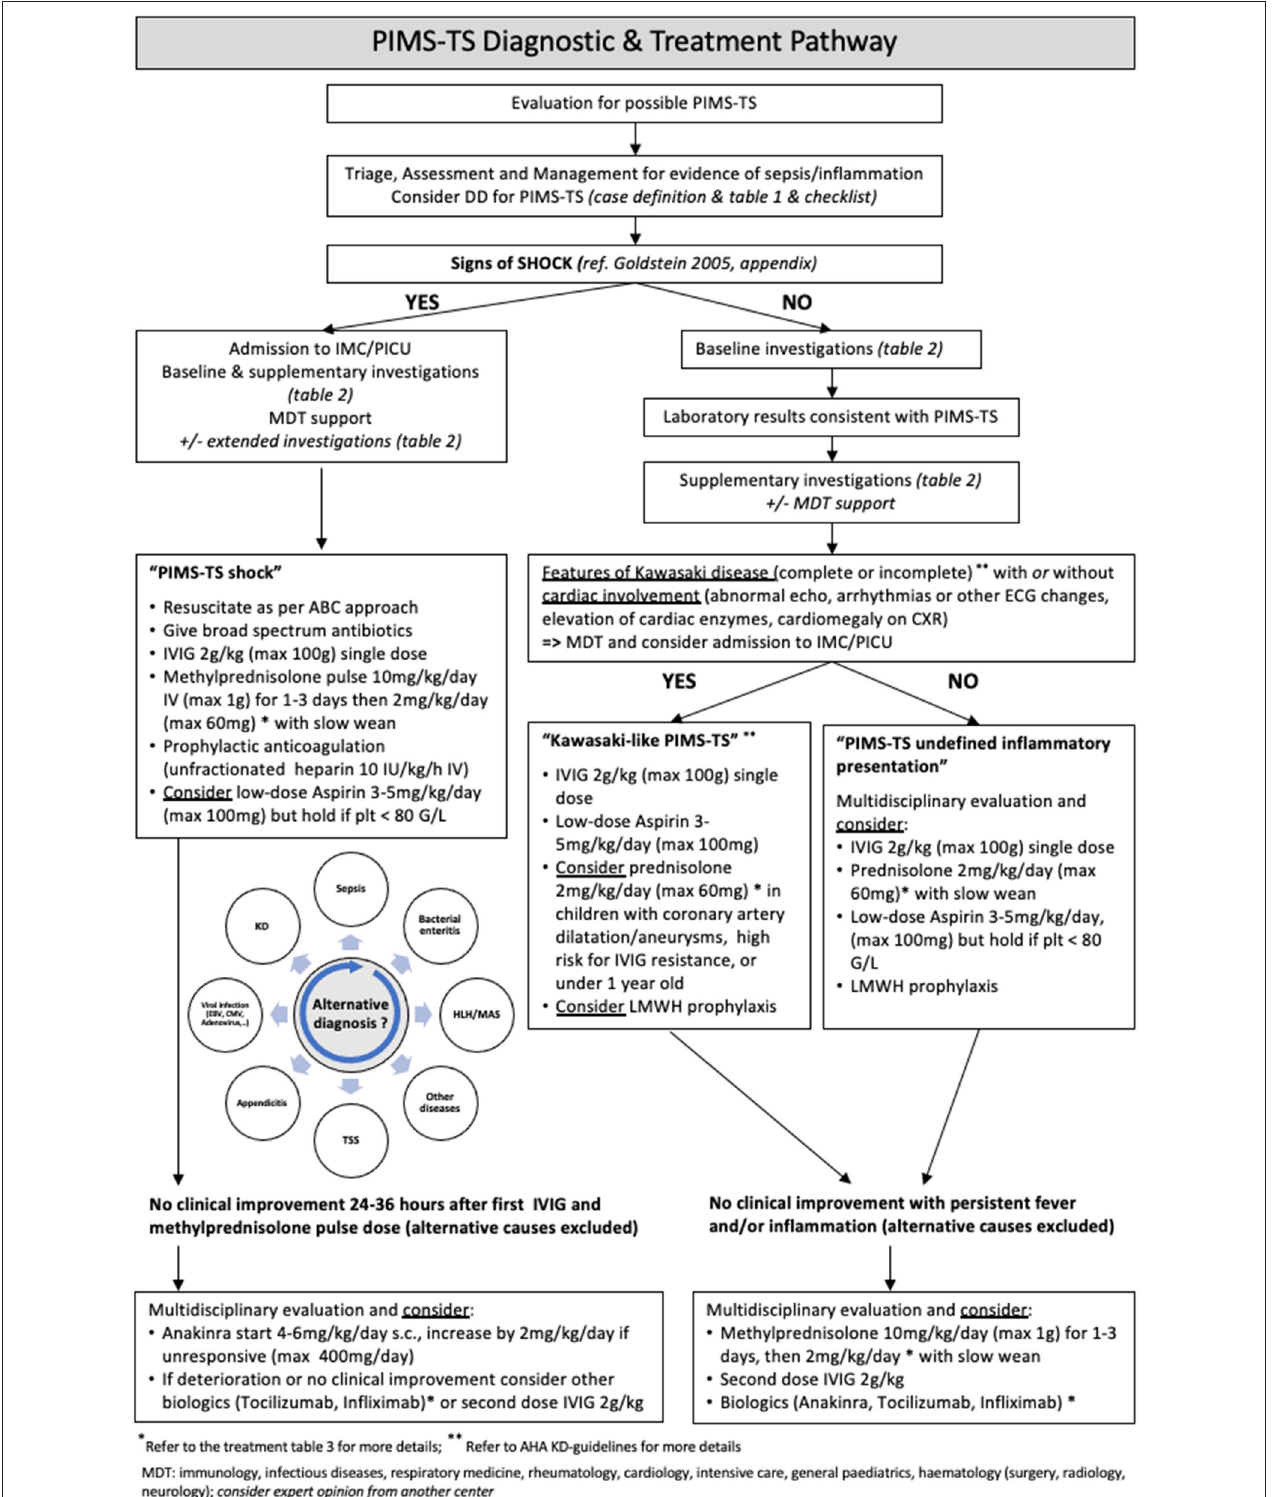
FIGURE 1 | PIMS-TS diagnostic and therapeutic